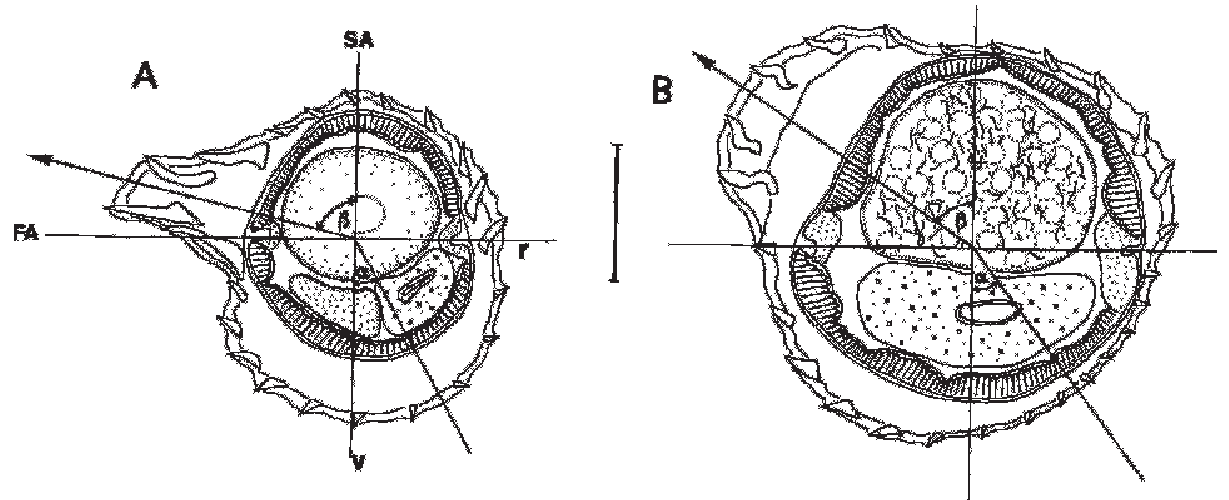
3. – Transverse sections at mid-body of two species of the genus Heligmonoides Baylis, 1928. A. H. parvulus (Desset, 1966), syntype female, 2.25 mm long, section at 1.050 mm from apex; α = 30°, β = 76°. B. H. speciosus (Konno, 1958), syntype male, 3.5 mm long, sec- tion at 1.75 mm from apex; α = 35°, β = 55°. Both sections are orientated as A. Axis (axes) of orientation represented by the arrow. α : angle of inclination of the right axis to the sagittal axis. β : angle of inclination of the left axis to the sagittal axis. Abbreviations: r: right side; v: ventral side; SA: sagittal axis; FA: frontal axis passing through the lateral fields. Scales: 30